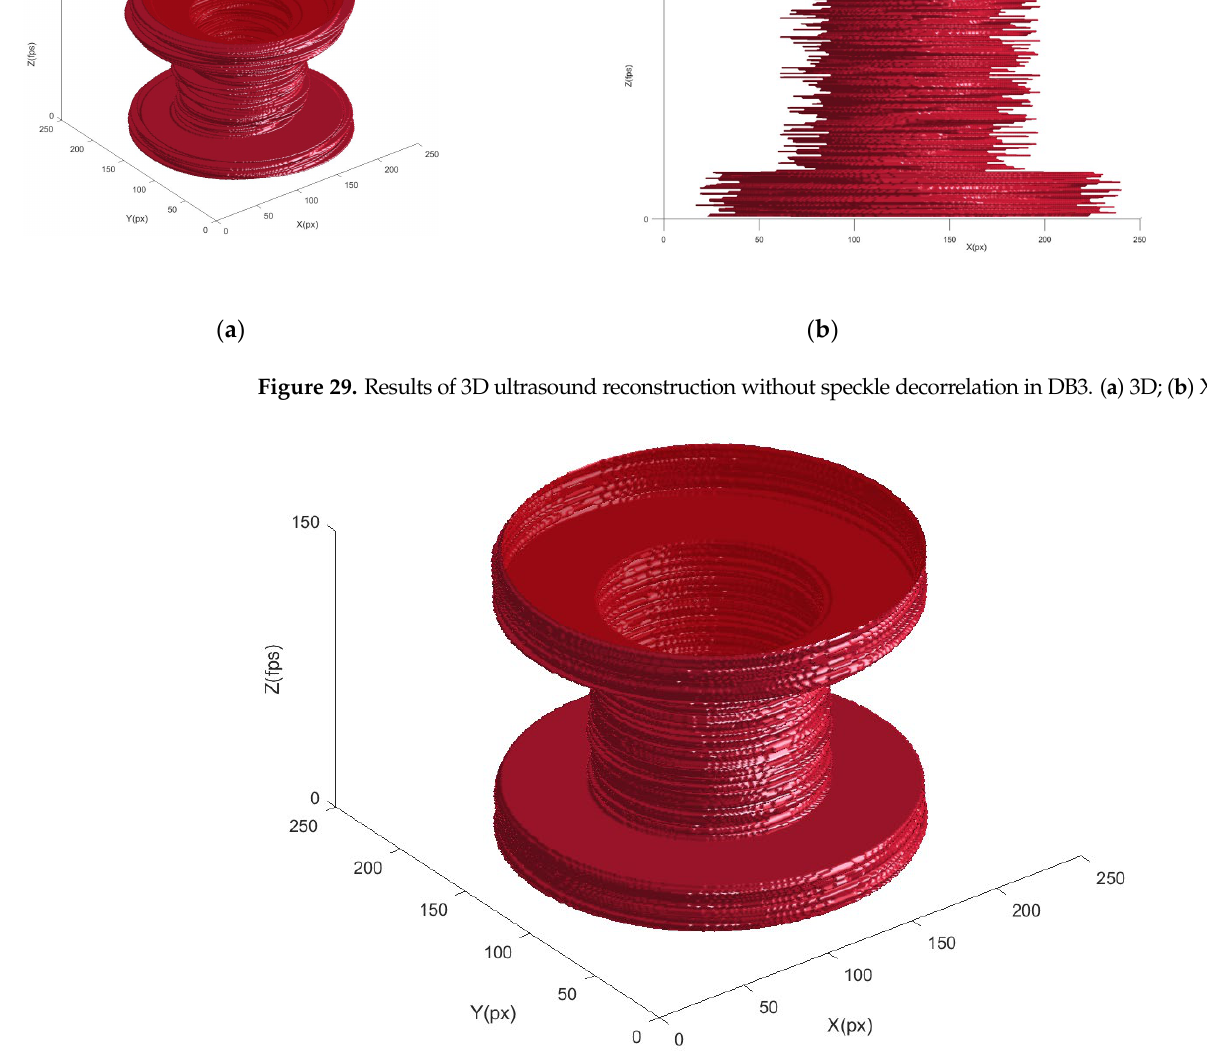
Figure 30. Results of 3D ultrasound reconstruction using SPRAO in DB3 .